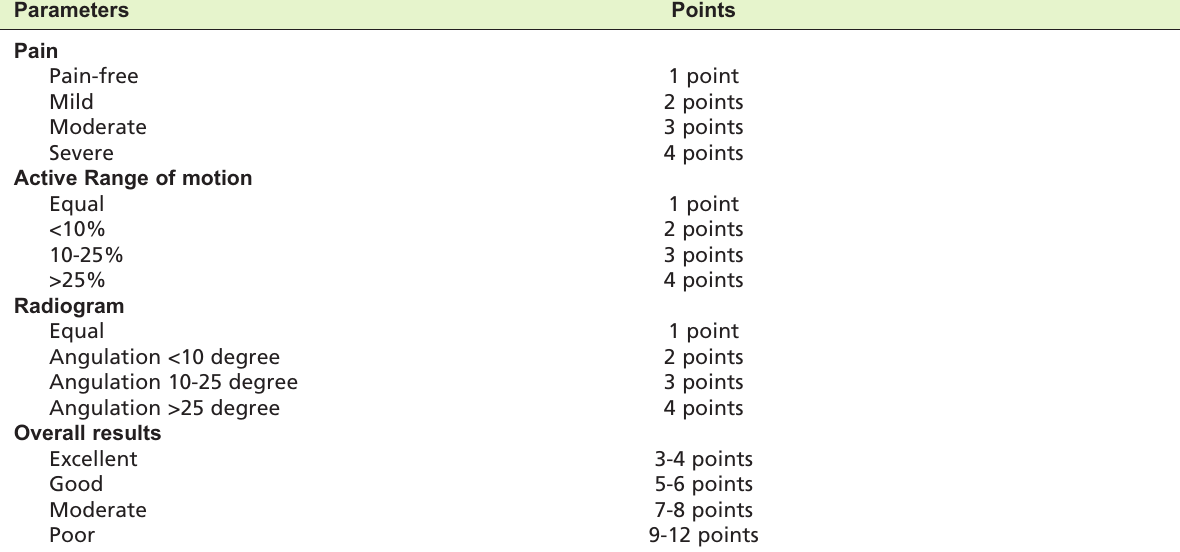
Scoring system for overall results as suggested by Zimmermann et al 22 Table I: